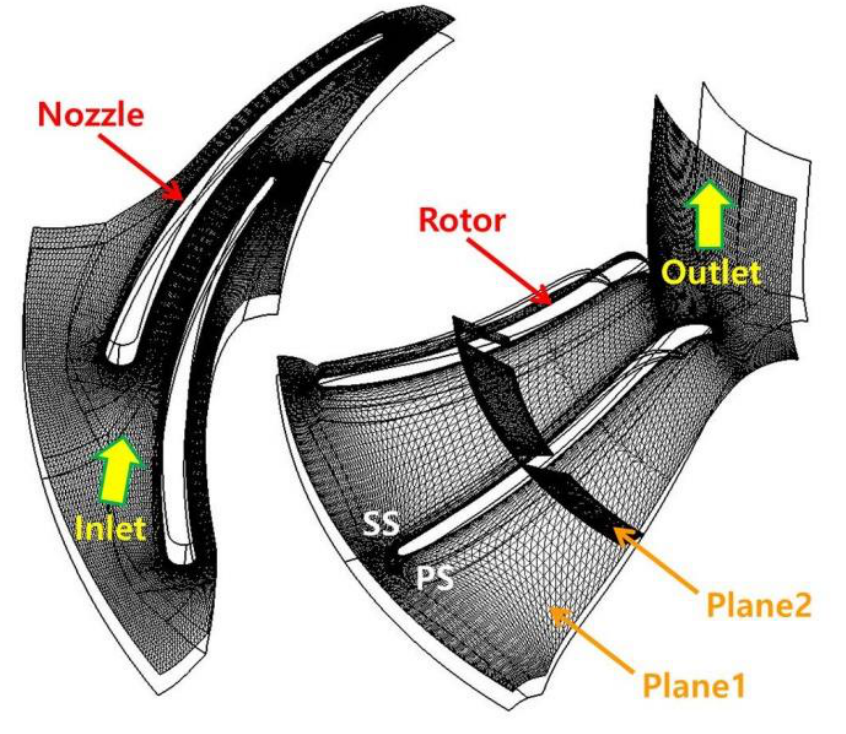
Figure 14. Locations of Planes 1 and 2 in the CFD domain.